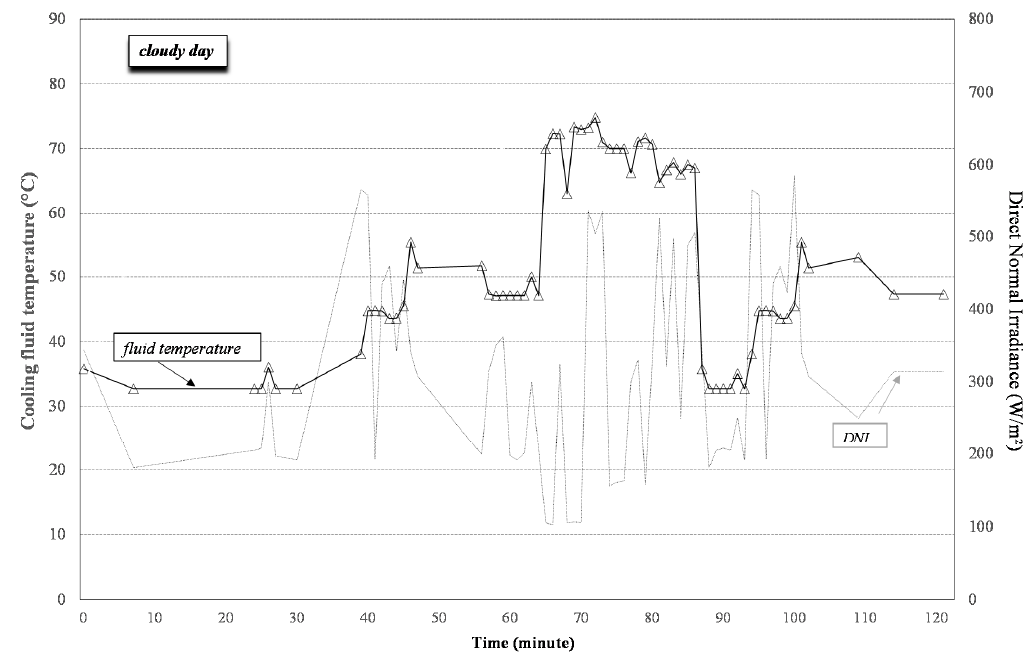
Figure 8. Experimental values of the cooling fluid outlet temperature of the CPV/T system in a cloudy cloudy day.